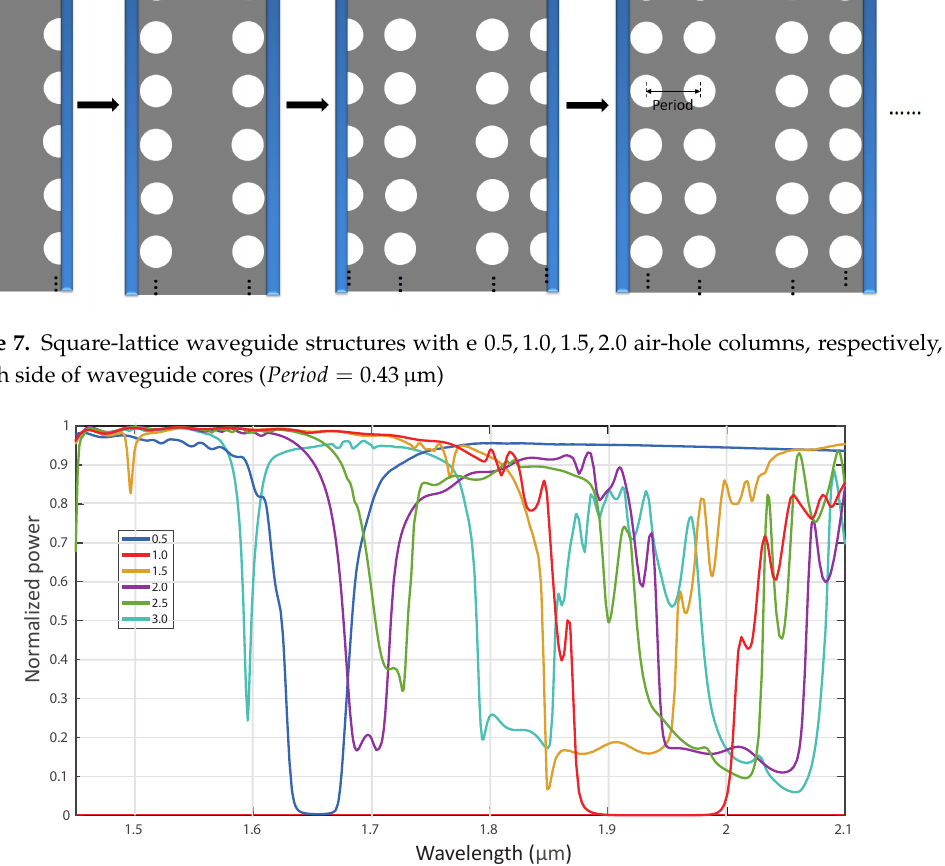
Figure 8. Spectra of the square lattice waveguides with different columns of air